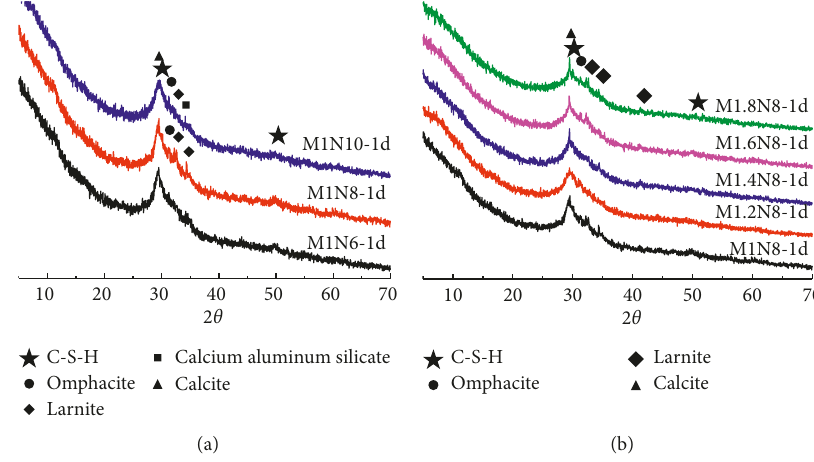
Figure 6: The XRD diffractograms of AAS pastes at different Na